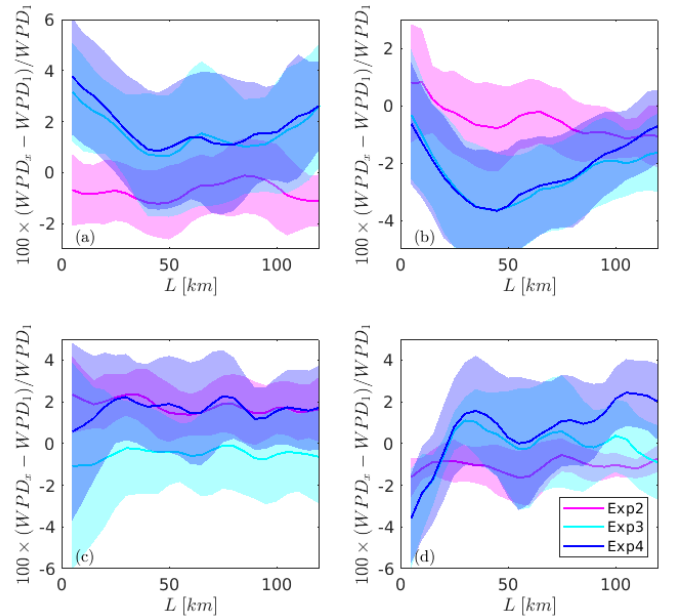
Figure 11. The relative difference of WPD between the sensitivity experiments (i.e., Exp2, Exp3, and Exp4) and Exp1 for the four chosen areas: ( a ) A, ( b ) B, ( c ) C and ( d ) D in July 2015. The shaded areas represent the standard